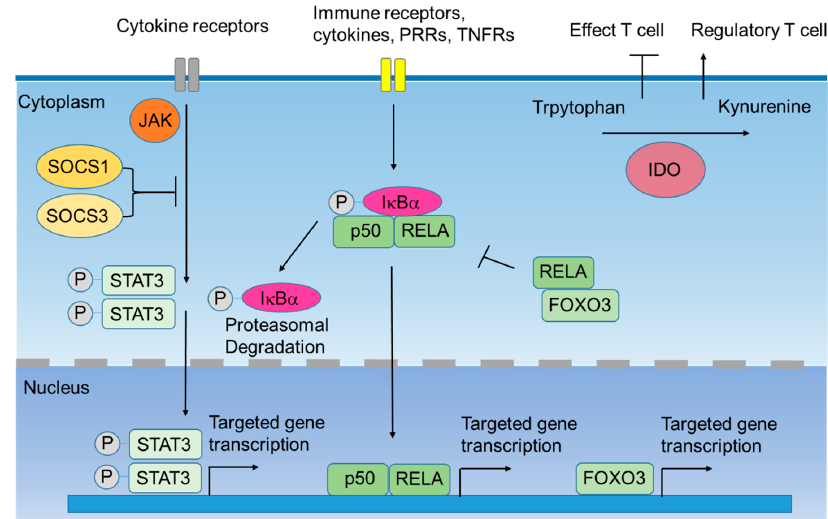
Figure 1. Intracellular negative immune regulators of dendritic cells (DCs). When immune receptors are triggered, downstream kinases such as Janus kinase (JAK) are activated. JAK then activates the signal transducers and activators of transcription 3 (STAT3). Nuclear translocation of phosphorylated-STAT3 (P-STAT3) activates the transcription of STAT3-targeted genes. Silenced Suppressor of Cytokine Signaling (SOCS) 1 and SOCS3 can interact with JAK and block the phosphorylation of STAT3, inhibiting the transcription of STAT3-mediated cytokines. In addition, the canonical nuclear factor- κ B (NF- κ B) pathway is also triggered by immune receptors. This signal leads to the phosphorylation of the I κ B kinase α (I κ B α ), which associates with the dimers of p50 and RELA (or c-REL). Proteasomal degradation of phospho-I κ B α (P-I κ B α ) results in the nuclear translocation of canonical NF- κ B family members, which activates the transcription of downstream genes. Forkhead box O3 (FOXO3) is a transcription factor that inhibits the transcription of pro-inflammatory cytokines. Besides, cytosolic FOXO3 binds to RELA, and this complex decreases the nuclear translocation of NF- κ B. Indoleamine 2,3-doixygenase